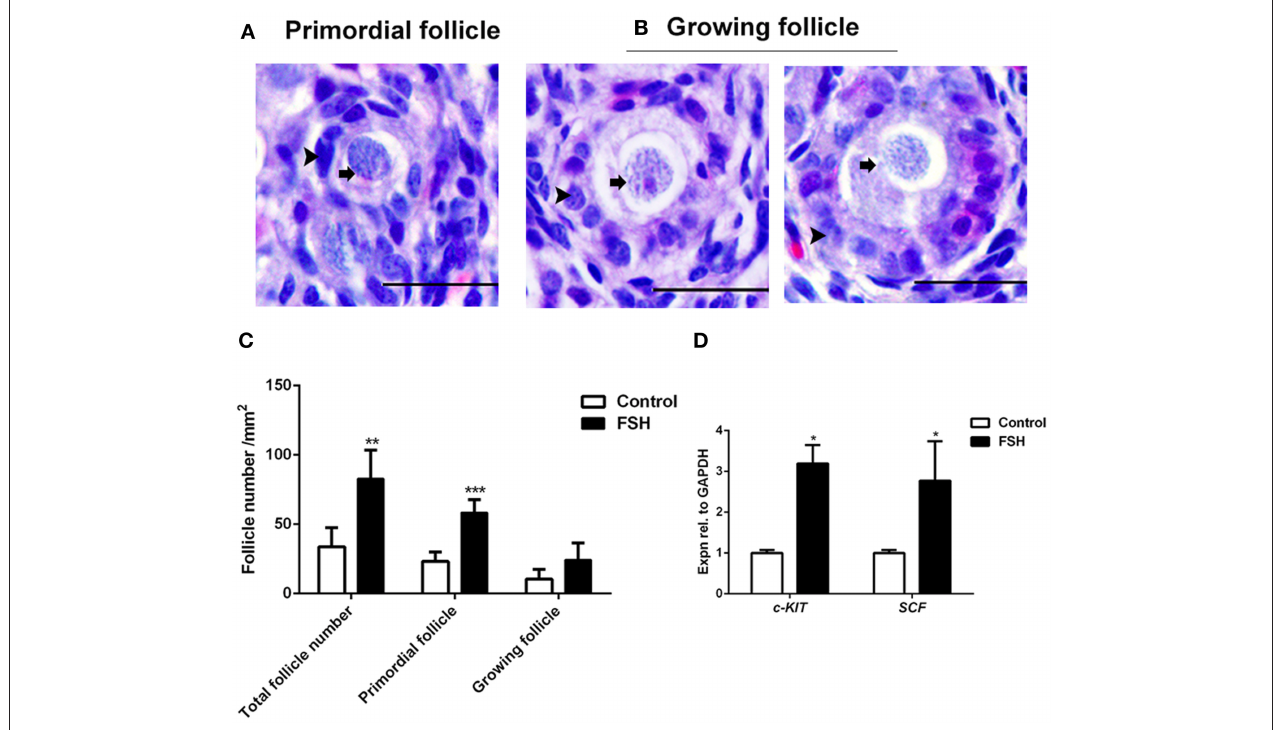
FIGURE 4 | Effects of FSH treatment on chicken folliculogenesis in vivo . (A,B) Morphology of the primordial and growing follicles in 6-day-old chicken ovaries. Scale bar: 20 µ m. Arrowheads and arrows represent the somatic cells and oocytes, respectively. (C) Changes in the primordial and growing follicle numbers after FSH treatment. (D) The c-KIT and SCF mRNA expressions were measured by qRT-PCR in ovaries from the 6-day-old chickens after FSH treatment at day 4. GAPDH was used as the normalization control. T -tests were used to determine statistically significant differences. The values are the mean ± SEM of six experiments. Asterisks indicate significant differences (* P < 0.05, ** P < 0.01, *** P <